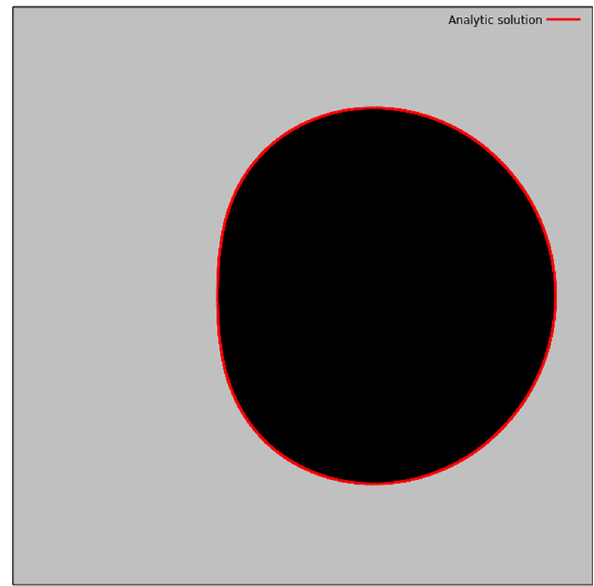
Fig. 4 Hamiltonian constraint in logarithmic scale for a photon that Fig. 6 Numerical (black area) and analytical (red rim) black hole escapes. Upper left panel: RK Dormand-Prince; upper right panel: shadow in the Kerr space-time with a spin parameter a = 0 . 98 for RK Cash-Karp; lower left panel: RK Fehlberg; lower right panel: an observer located in the equatorial plane, θ 0 = π/ 2 at r 0 = 1000. BS algorithm. The initial conditions are: r 0 = 100, θ 0 ≈ 1 . 570796, The domain of the image plane is − 8 ≤ x , y ≤ 8. This result is in φ ≈ 1 . 570796, p ≈ − 0 . 989953, p ≈ − 1 . 009723, p θ ≈ 1 . 870000 agreement with the obtained by [35], but with a dimensionless spin t r 0 parameter a = 0 . and p φ ≈ 2 . 000098